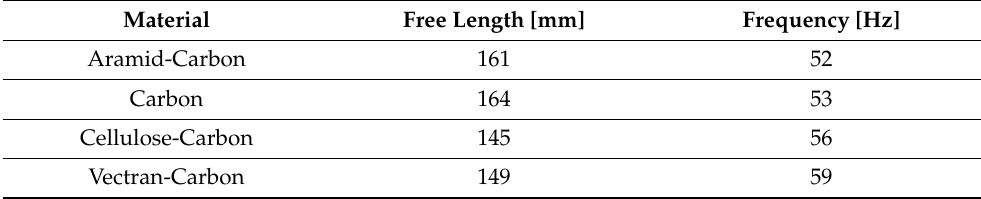
Table 4. Free length and damped natural frequency.